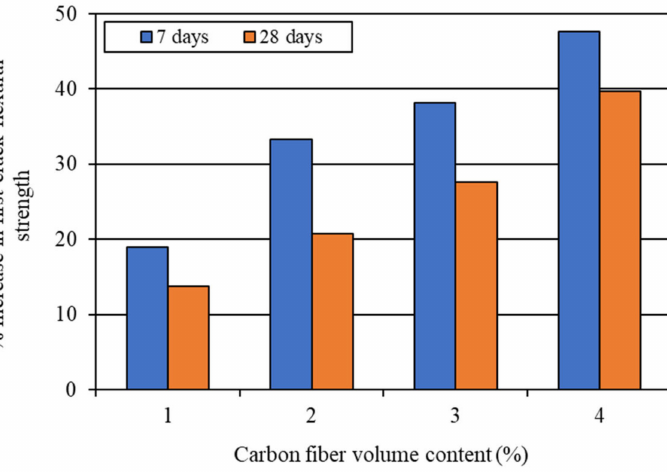
Figure 8. Increase in first-crack flexural strength due to the incorporation of carbon